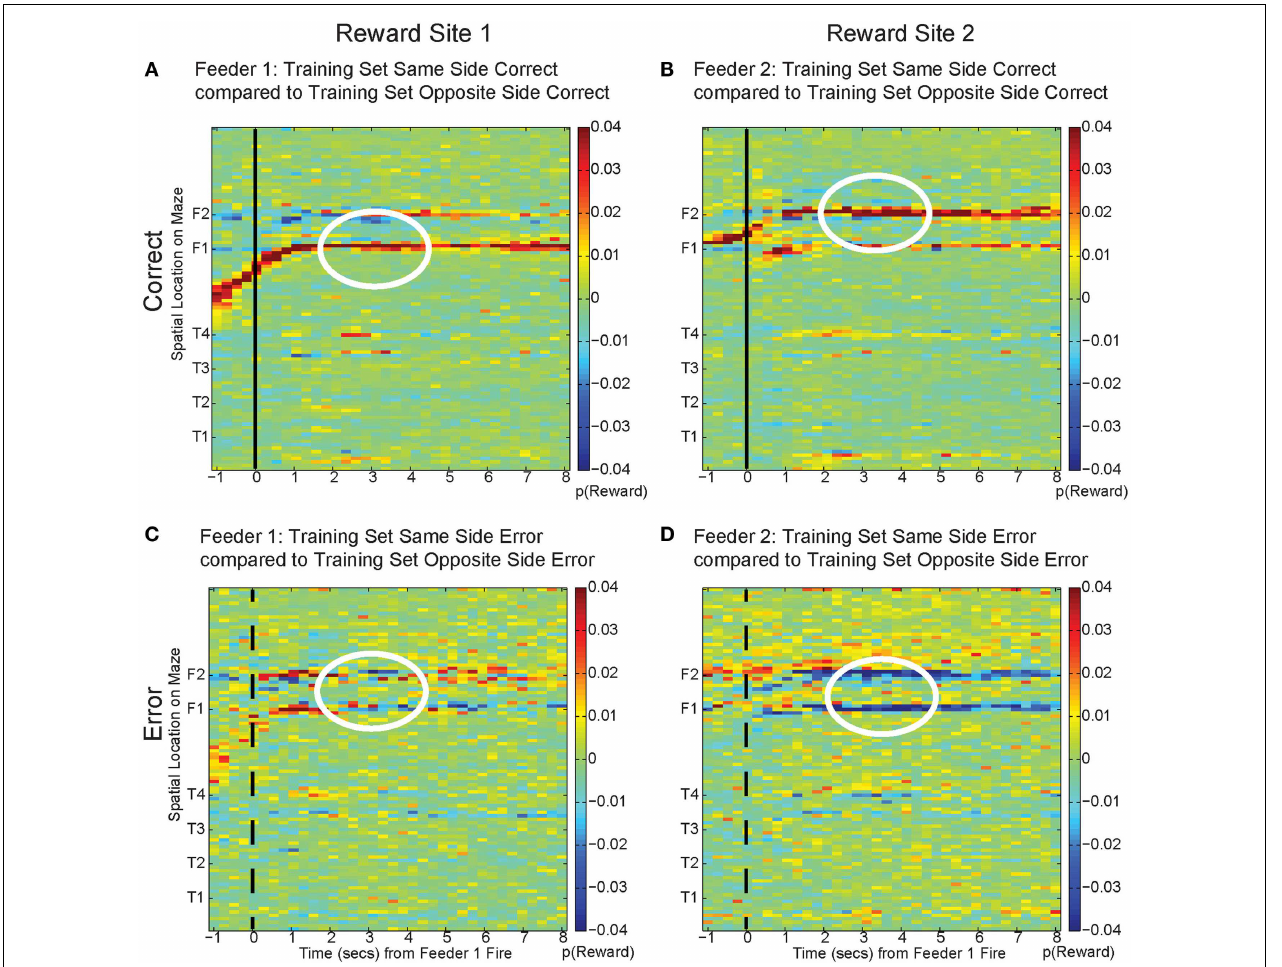
(B) : white circle, Feeder 2].This indicates that decoding remains local for the duration of the rats’ stay at the feeder and fails to represent other possible locations on the maze. However, when the rat chooses incorrectly, upon crossing into the zone where he would have heard the reward trigger (dashed black line, incorrect), neural ensembles switch and represent the would-have-been rewarded side, as indicated by the strong blue color at the feeder locations [ p (same) < p (opposite), (C) : white circle, Feeder 1 and (D) : white circles Feeder 2].This indicates that neural representations during errors more closely resemble the activity at the would-have-been rewarded feeder.The decoding does not become random; instead p (Reward same ) decreases, while p (Reward opposite )